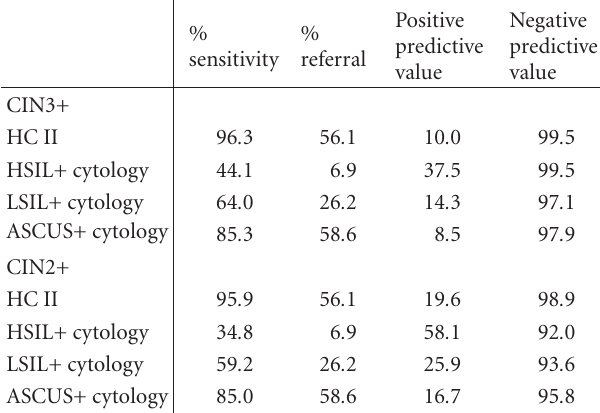
Table 1: Triage test performance of HC II and cytology